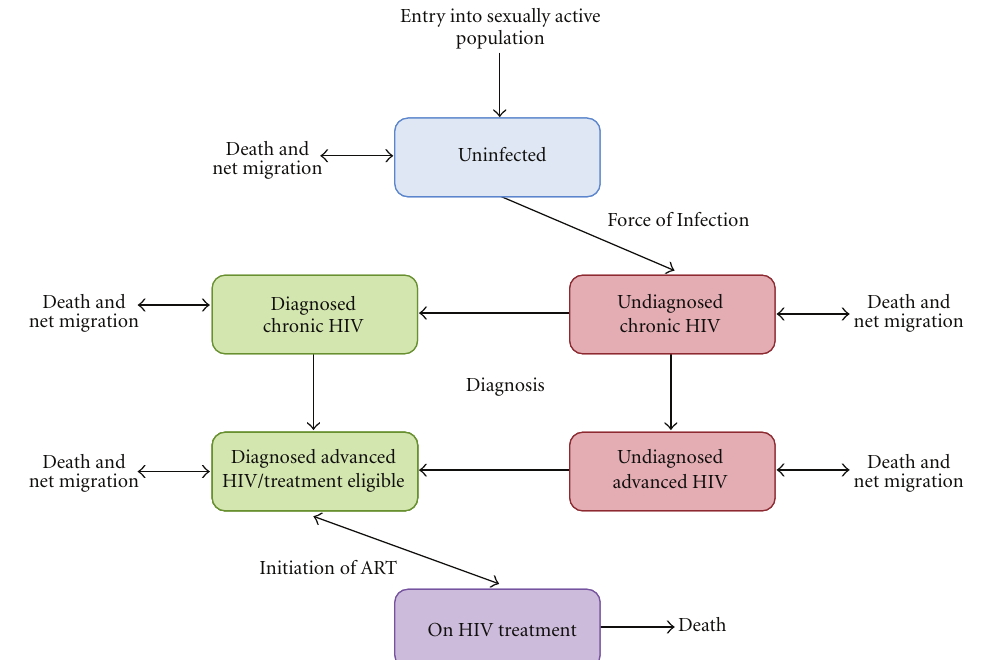
Figure 1: Schematic diagram of the stages of HIV infection described by the model and the progression of people through these stages due to infection, disease progression, diagnosis, and initiation of treatment. These stages are replicated for the urban and rural population in PNG with migration (except for people on treatment) between corresponding infection stages. People enter the uninfected population when they become sexually active and leave the population due to natural or HIV-related